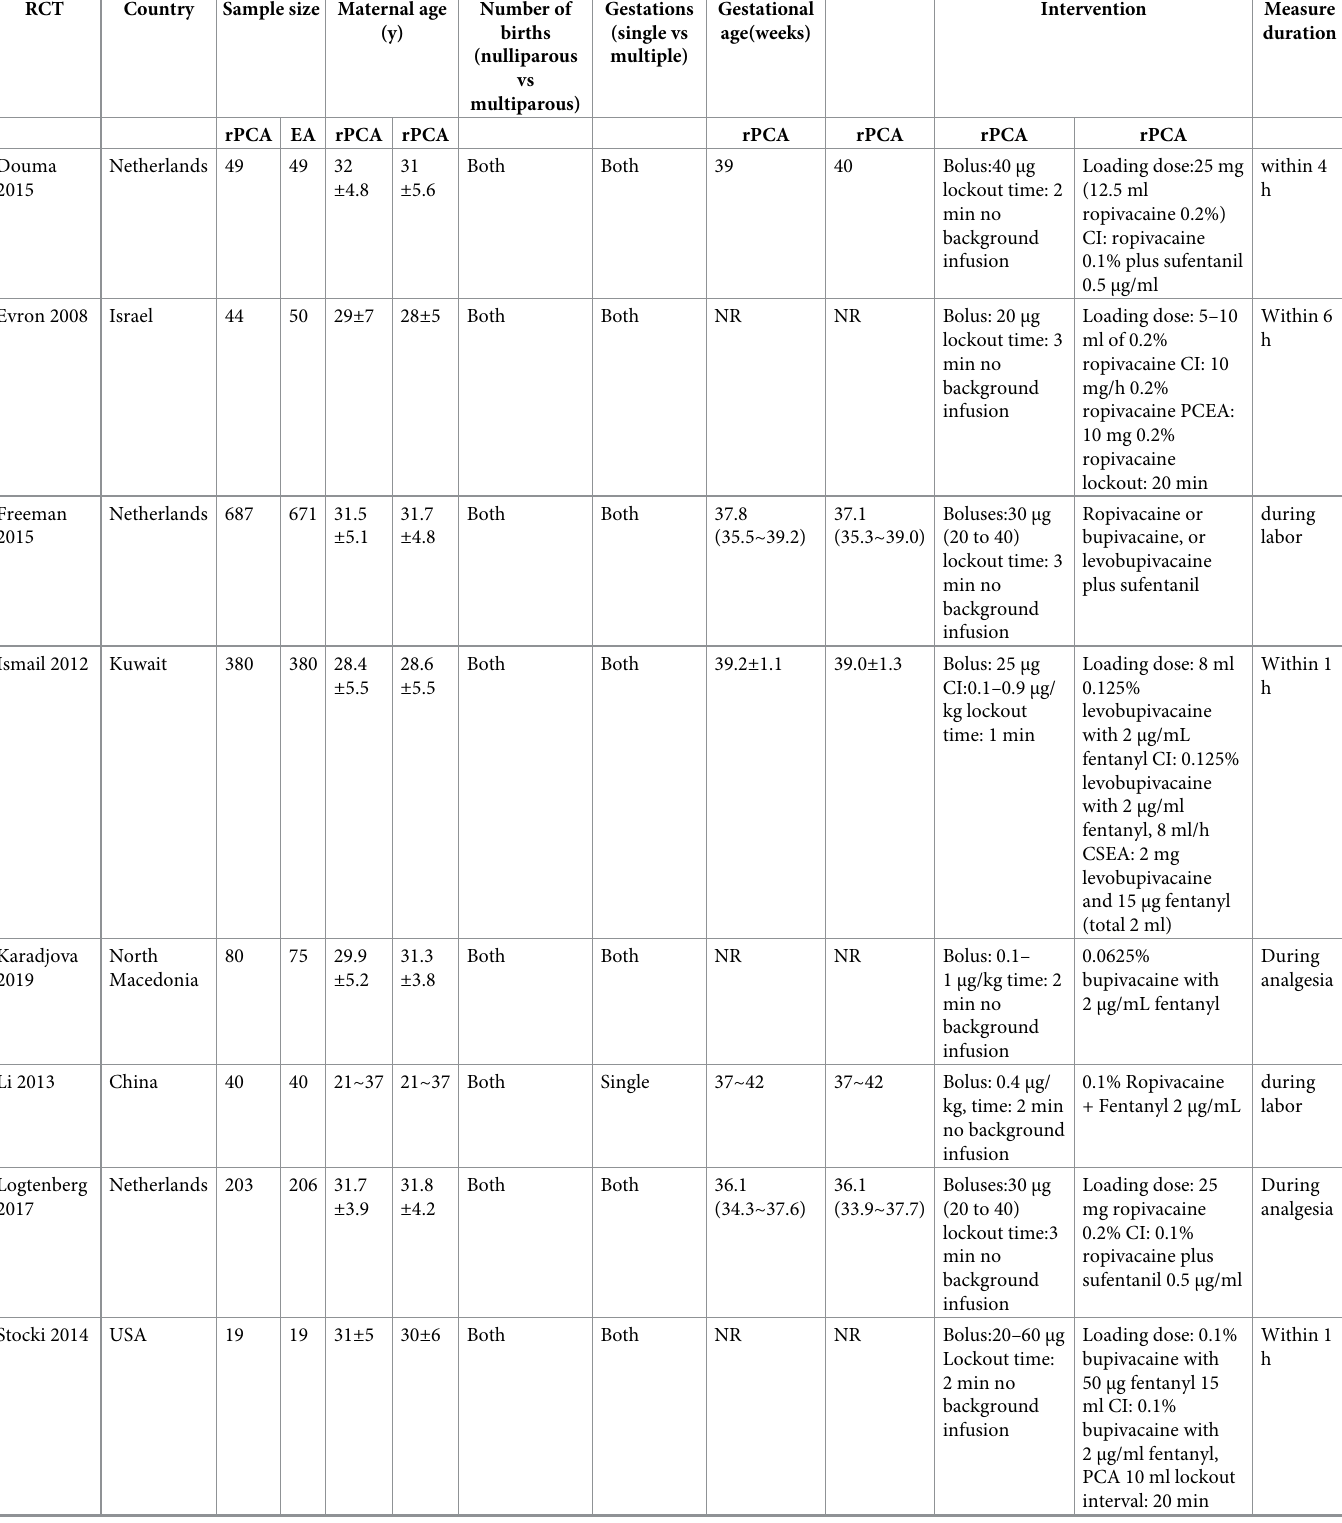
Table 1. The characteristics of included